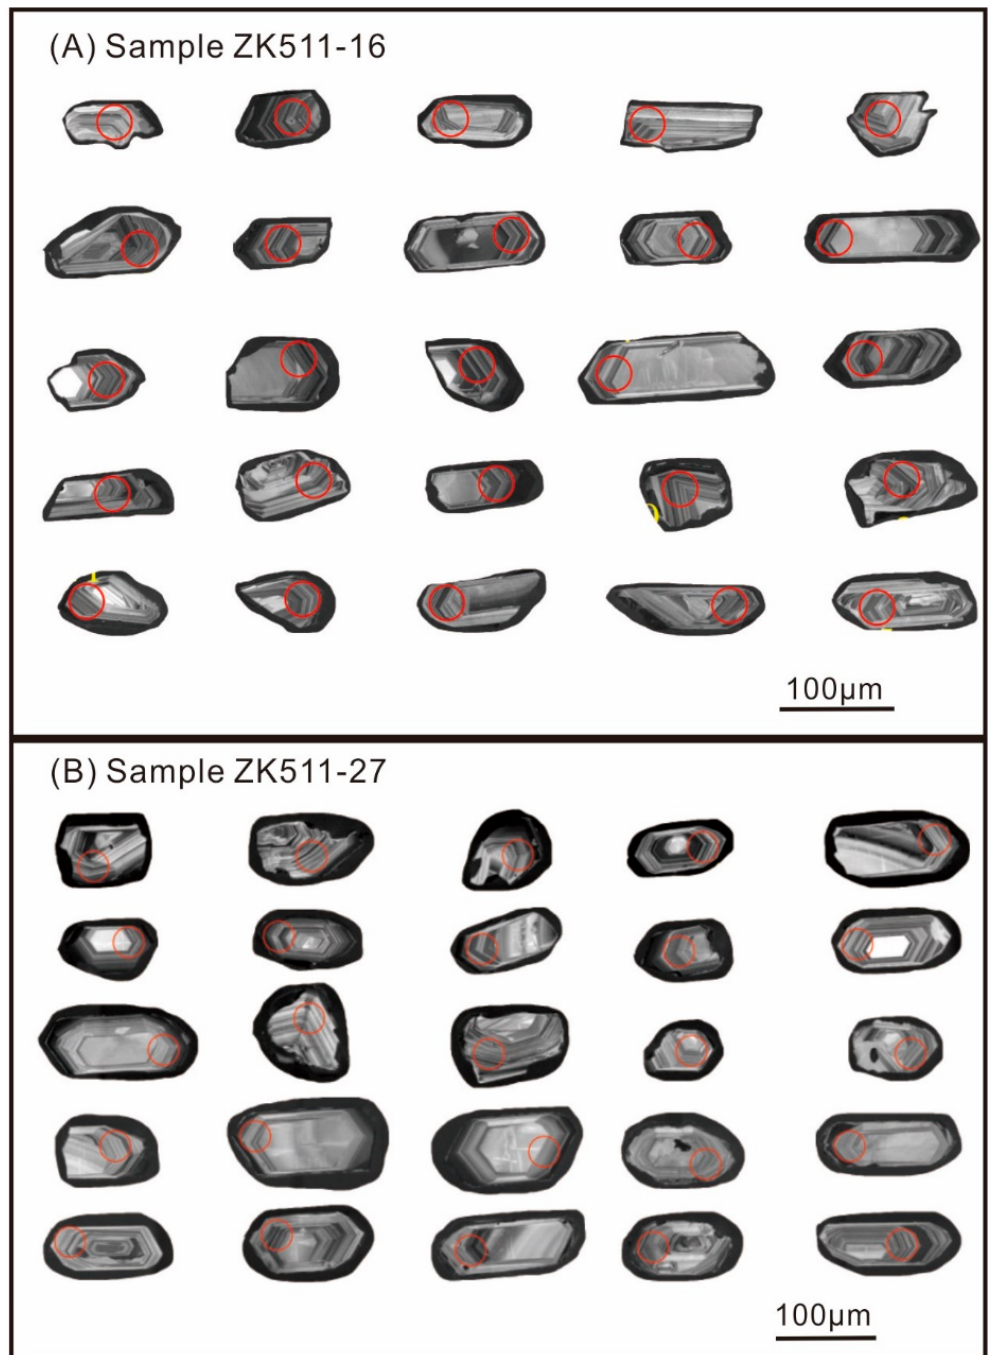
Figure 4. Zircon cathodoluminescence pictures of laser ablation inductively coupled mass (LA-ICP-MS) U–Pb dating of granite porphyries in the Jiangjiatun Mo deposit ( A : sample No. 511-16 and B : 511-27).